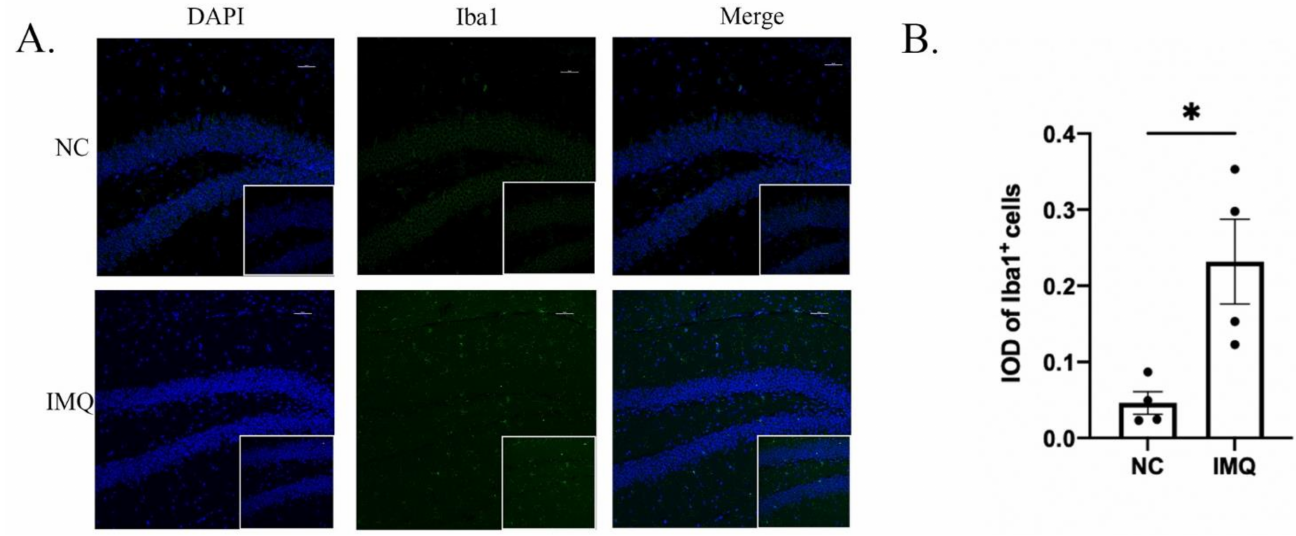
Figure 5. Iba1 immunoreactivity of microglia in the hippocampus of female mice. ( A ) Representative images of labeling for Iba1. ( B ) The integral optical density (IOD) of Iba1 + cells in hippocampus ( × 200), scale bar = 50 µ m. Each value represents the mean ± SEM. n = 4 animals per group. Two groups (NC, IMQ) were analyzed using t -test (* p <